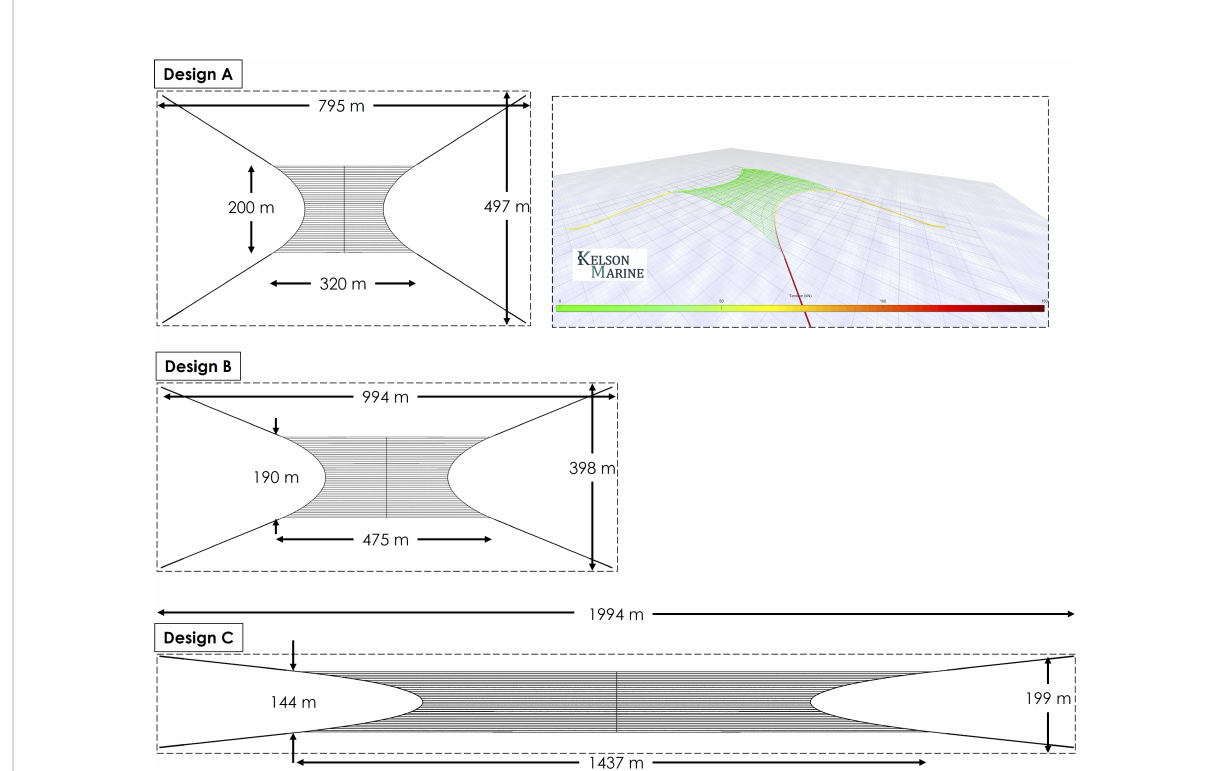
FIGURE 2 Overhead view of the three candidate modular cultivation structure designs. Designs differed by aspect ratio (length vs. width). Design “ C ” , with an aspect ratio of 10:1 was ultimately chosen as it provided the most available growing substrate within the allotted 100 acre lease footprint. Inset: Simulation of Design “ A ” showing tensions in structural lines in 1-year storm